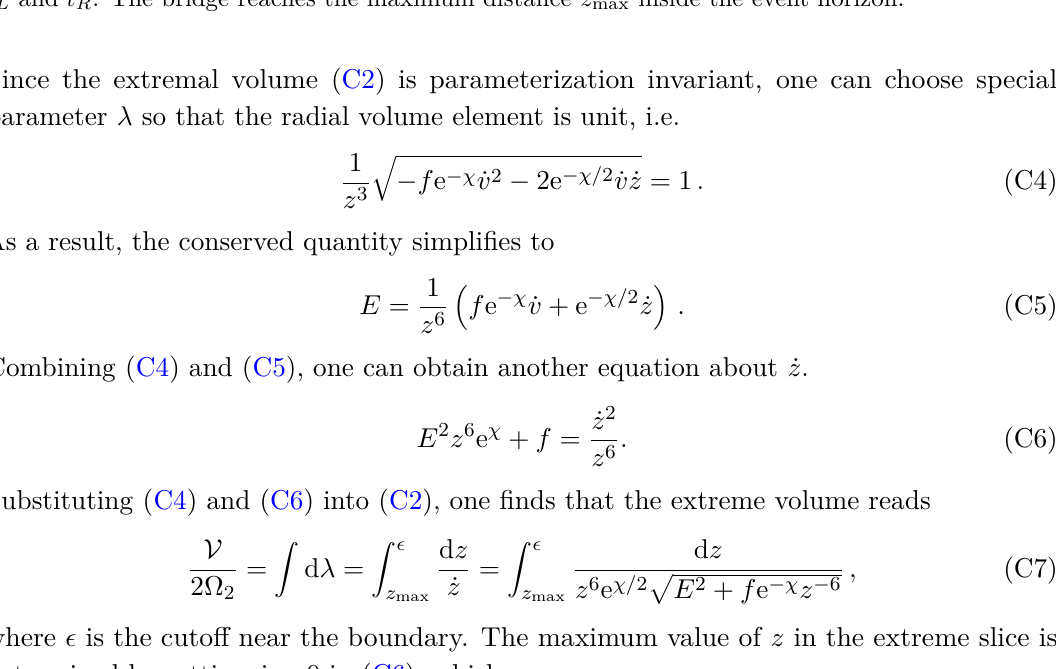
Figure 19 . A representation of the maximal wormhole connecting the symmetric boundary time t L and t R . The bridge reaches the maximum distance z max inside the event